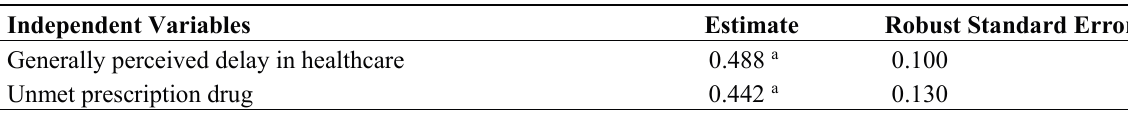
Table 5. Evaluated subjective health (ill health): Elderly of generally perceived delay in healthcare (aged 65+)—Results of OLS